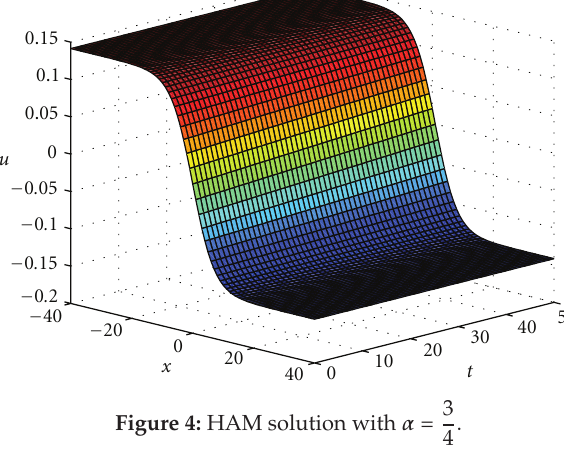
Figure 4: HAM solution with α (cid:8)